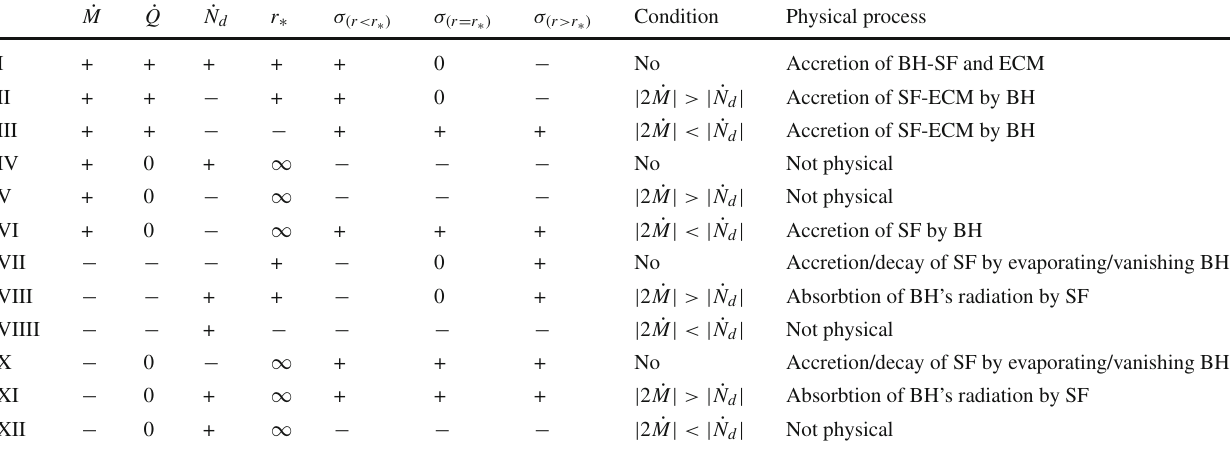
Table 1 General Bonnor–Vaidya BH and its dust SF parameters for (cid:2) = − 1. ECM denotes external charged matter which may contribute to the accretion